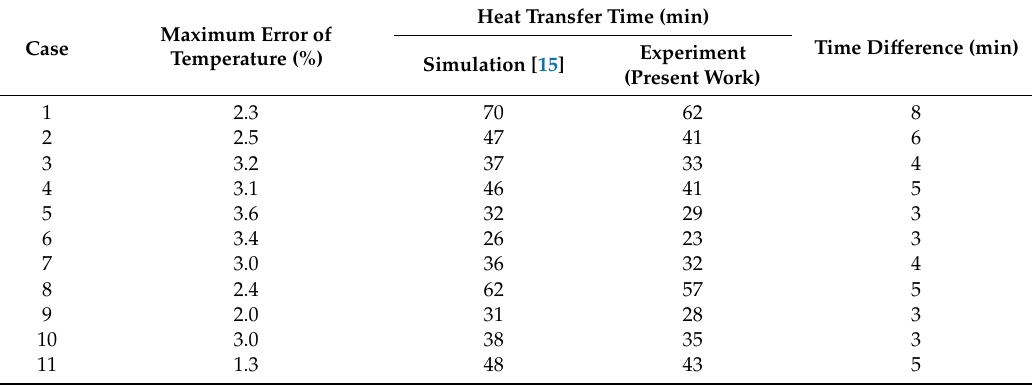
Table 3. Maximum error of the average water temperature in the tank, time to heat the tank water in the computational fluid dynamics (CFD) model and experiment, and the time di ff erence between the two results for all